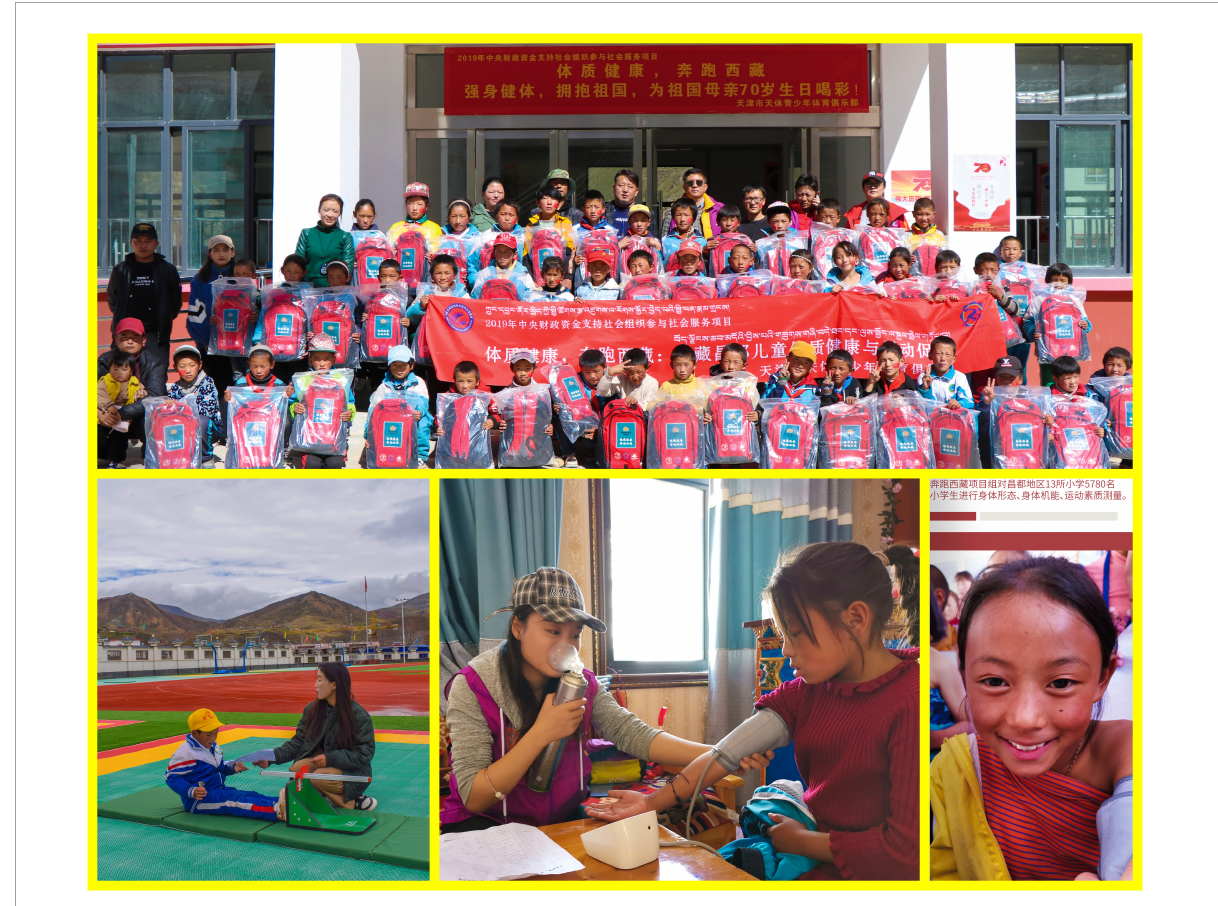
FIGURE1 Scenes from the data collection in Jomda County between August and October